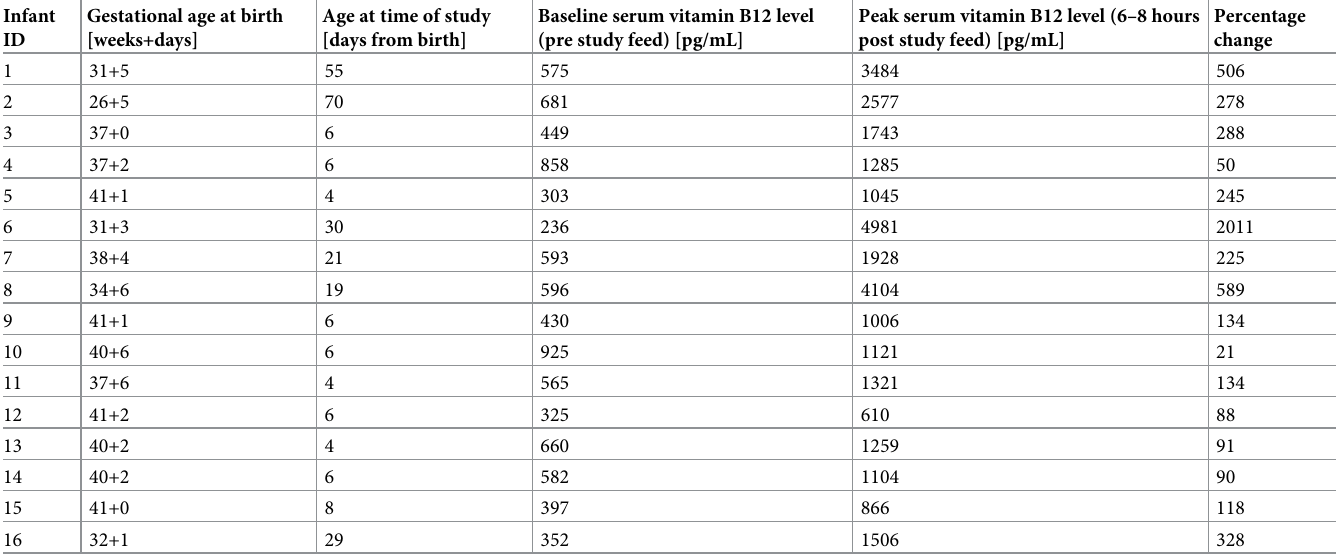
Table 2. Changes in serum vitamin B12 levels from baseline to 6–8 hours after the study feed.